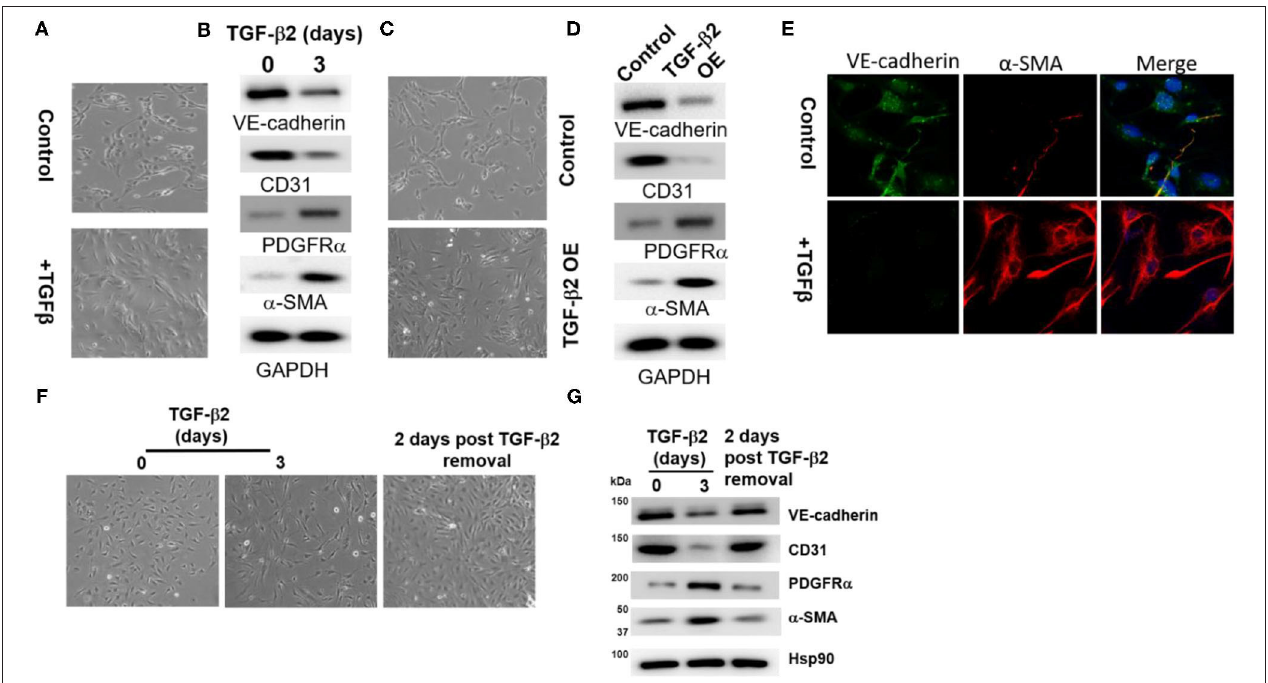
FIGURE 1 | TGF- β 2 induces EndMT in HAECs. (A) The morphological change of HAECs before and after a 3-day TGF- β 2 treatment. Scale bars, 100 µ m. (B) WB detection of the expression of the EndMT markers VE-cadherin, CD31, PDGFR α , and α SMA. Hsp90 was used as a loading control. (C,D) Same experiments were performed as those in (B,A) to control HAECs and TGF- β 2-overexpressing HAEC cells. (E) Immunostaining of VE-cadherin and α SMA in control HAECs and HAECs treated with TGF- β 2 for 3 days. Scale bars, 100 µ m. Experiments were repeated three times. (F) The morphological change of HAECs 2 days post TGF- β 2 removal following a 3-day TGF- β 2 treatment. (G) Immunoblotting for the expression of the EndMT markers VE-cadherin, CD31, PDGFR α , and α SMA in HAECs for (F) . Hsp90 was used as a loading